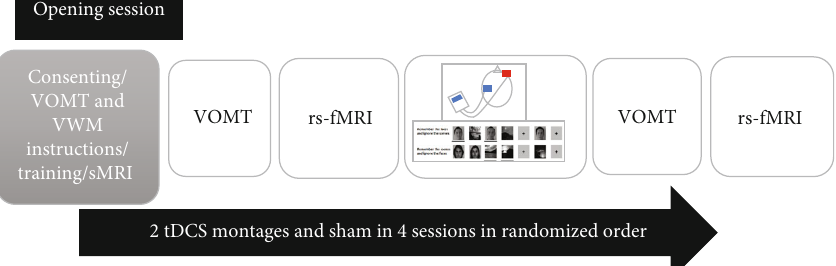
Figure 1: During the opening session, participants underwent sMRI and a neuropsychological examination and they practiced the VOMT and online VWM task. The VOMT and rs-fMRI were performed prior to and after each